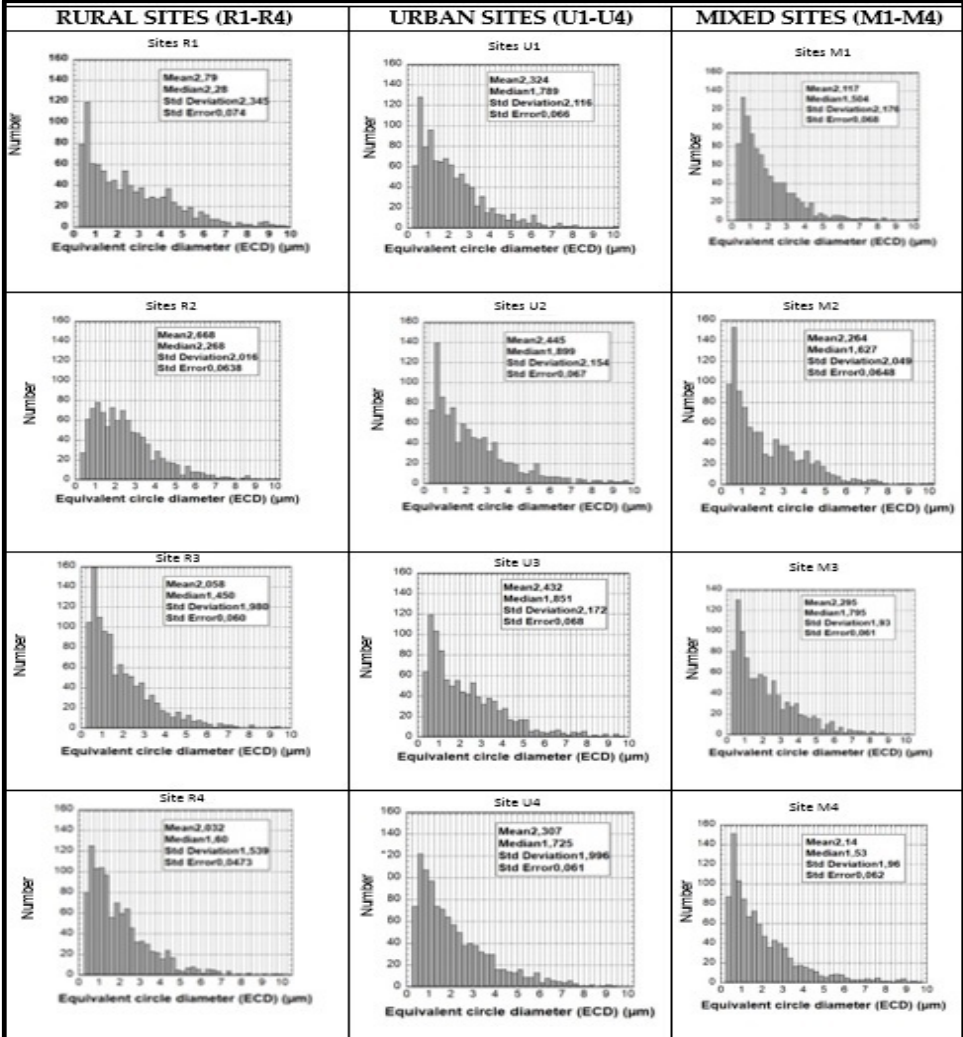
Figure 6. Site specific histograms showing particle distribution by equivalent circle diameter (ECD). Atmosphere 2022 , 13 , x FOR PEER REVIEW